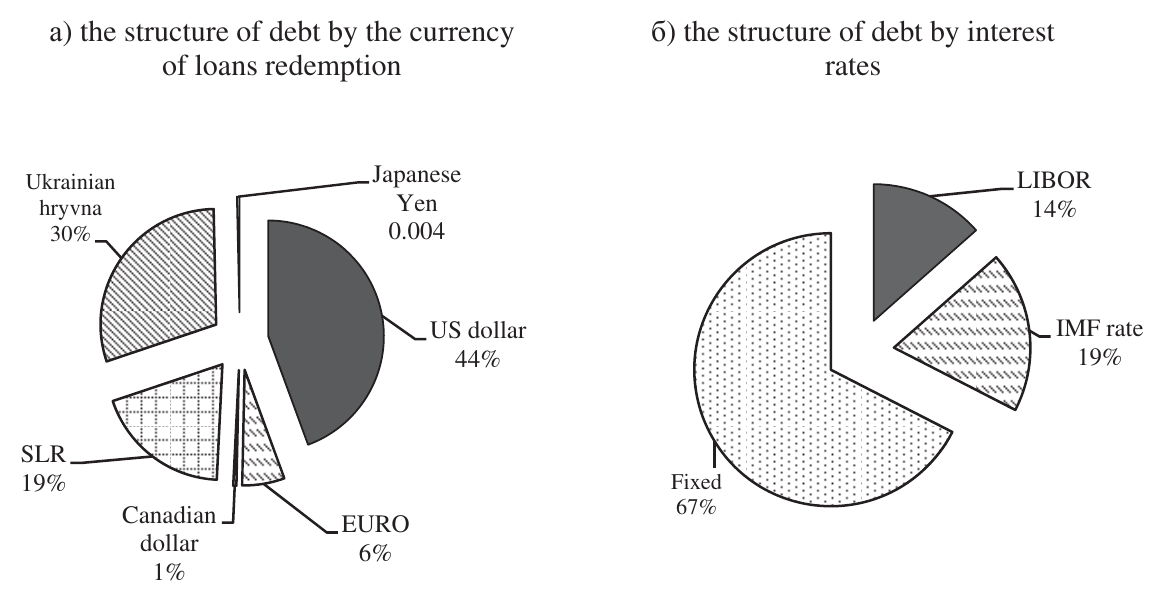
Fig. 7. The structure of external national debt of Ukraine in 2015